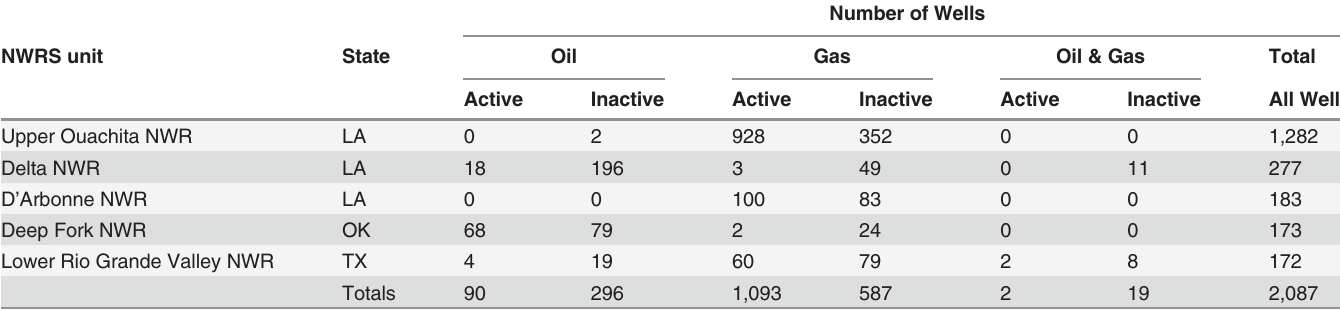
Table 5. NWRS units with the highest number of oil and gas wells (excluding other wells such as injection